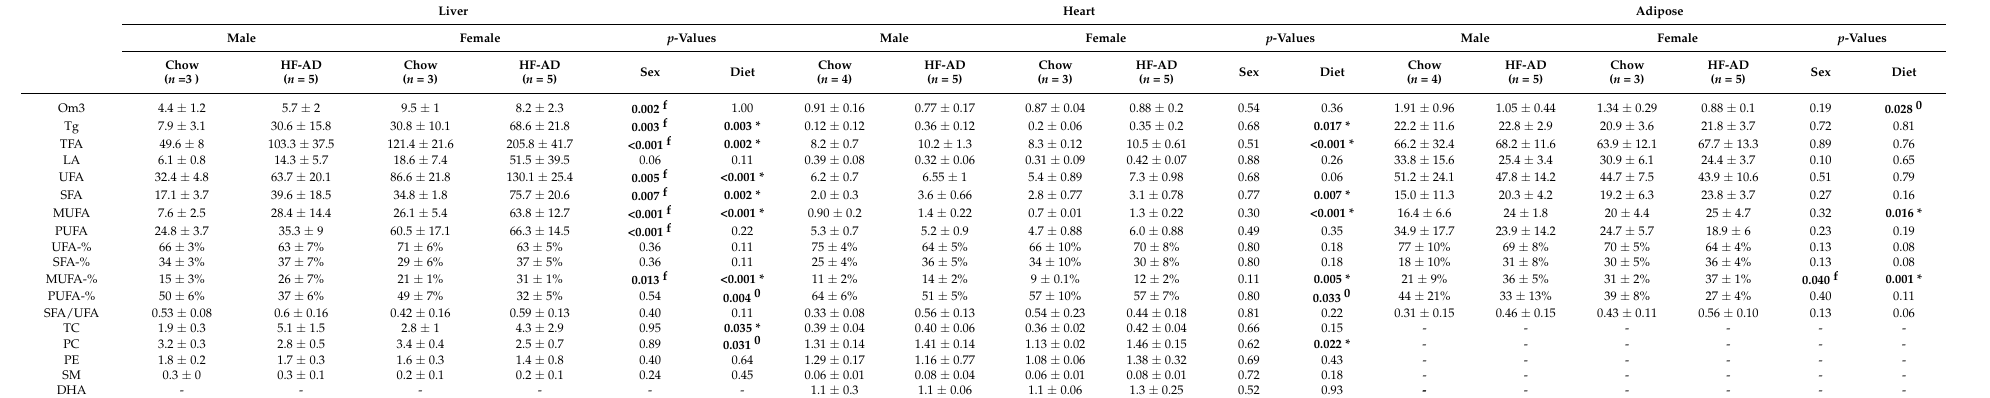
Table 1. Hepatic, cardiac, and adipose lipid concentrations (mM) indicated as mean ± standard deviation for both male and female chow and high-fat ad libitum (HF-AD)